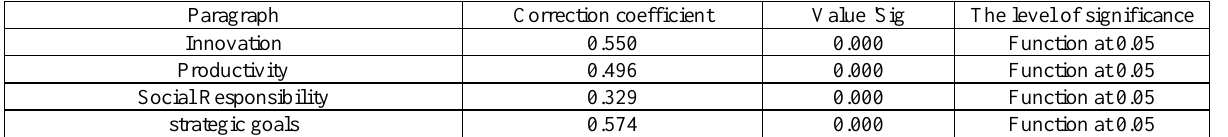
Table 20. Person's correlation transactions between the team and strategic goals Paragraph Correction coefficient Value 'Sig The level of significance Innovation 0.550 0.000 Function at 0.05 Productivity 0.496 Social Responsibility 0.329 Function at 0.05 strategic goals 0.574